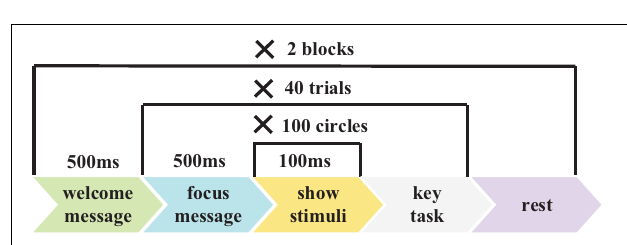
FIGURE 1 | The time course of rapid serial visual presentation (RSVP) paradigm.